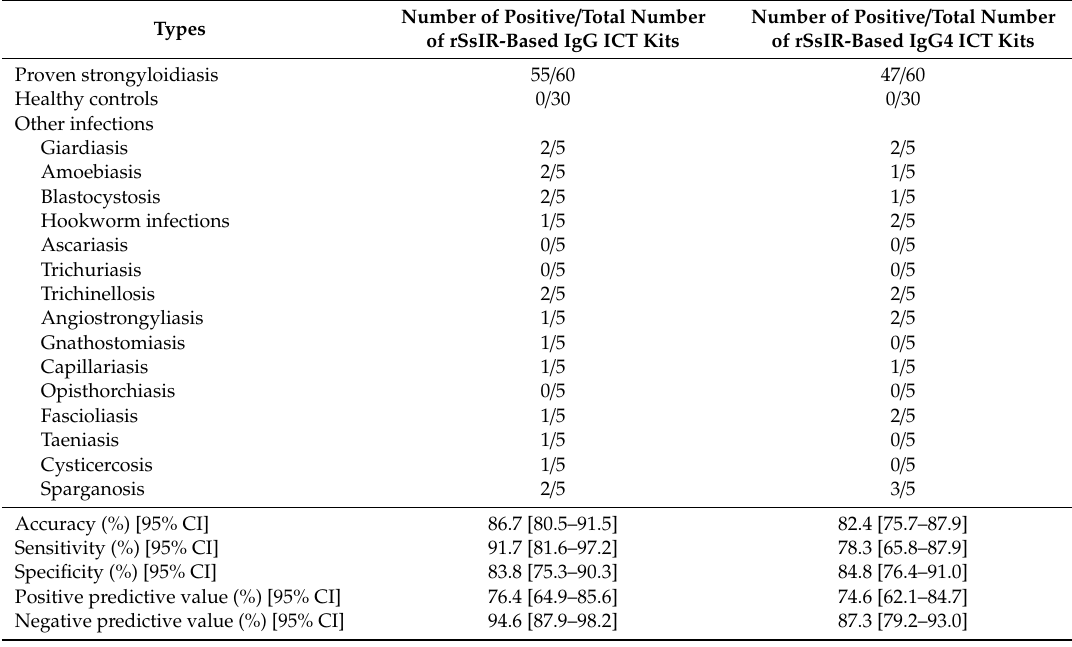
Table 1. Results by type of serum sample.